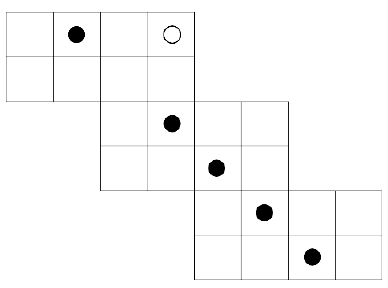
Figure 9 . The S -dual vacuum to the baryonic vacuum is the mixed mesonic-baryonic vacuum shown in this (cid:12)gure. S transformation on the (cid:12)rst SU(2) takes the baryonic vacuum to the vacuum presented in this (cid:12)gure. One can check that the two dual vacua carry the same U(1) charge C 0 = C .